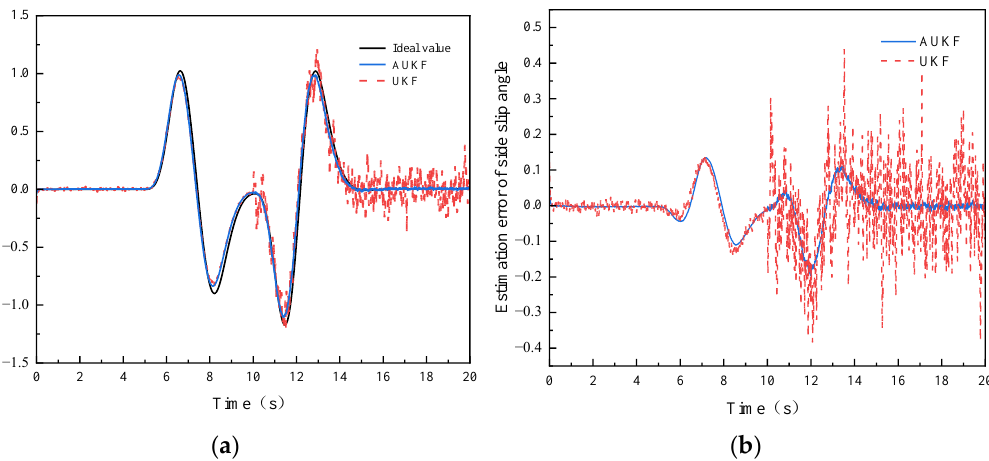
Figure 4. Simulation results of side slip angle. ( a ) Comparison of estimated results and ( b ) comparison of estimated error.